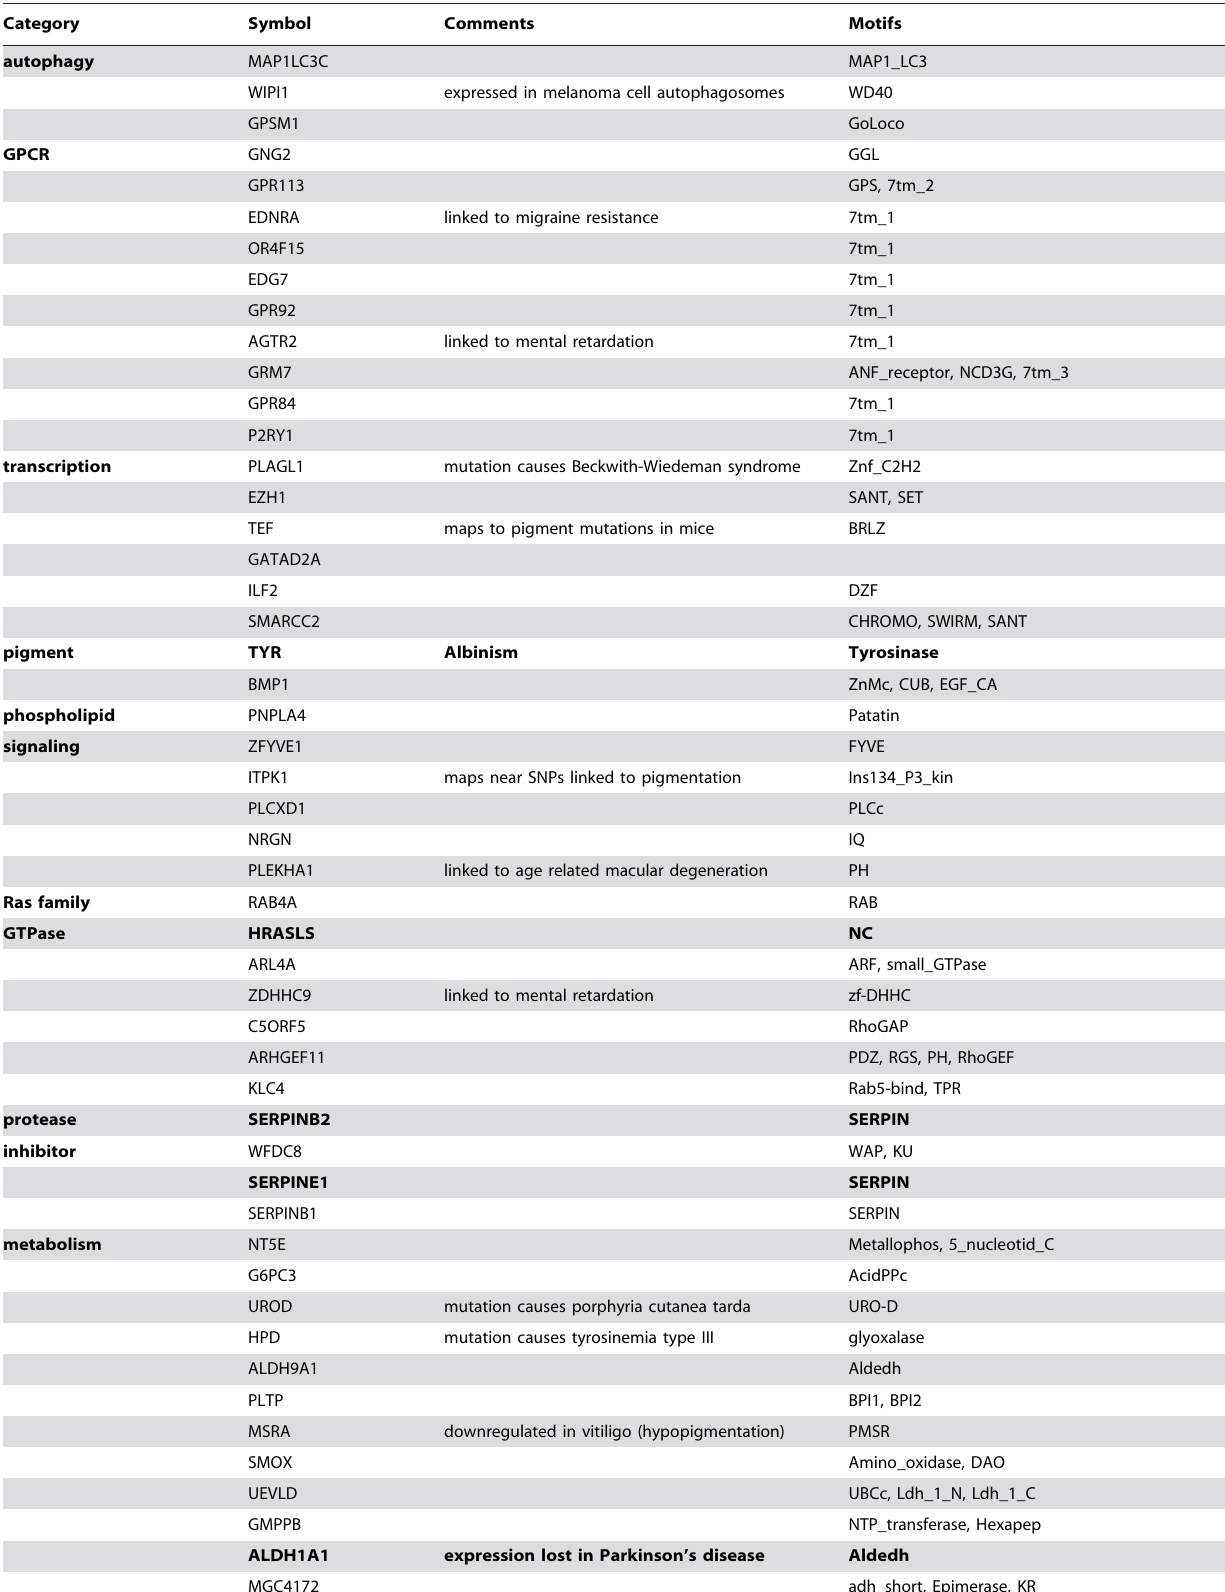
Table 1. Candidate Pigmentation